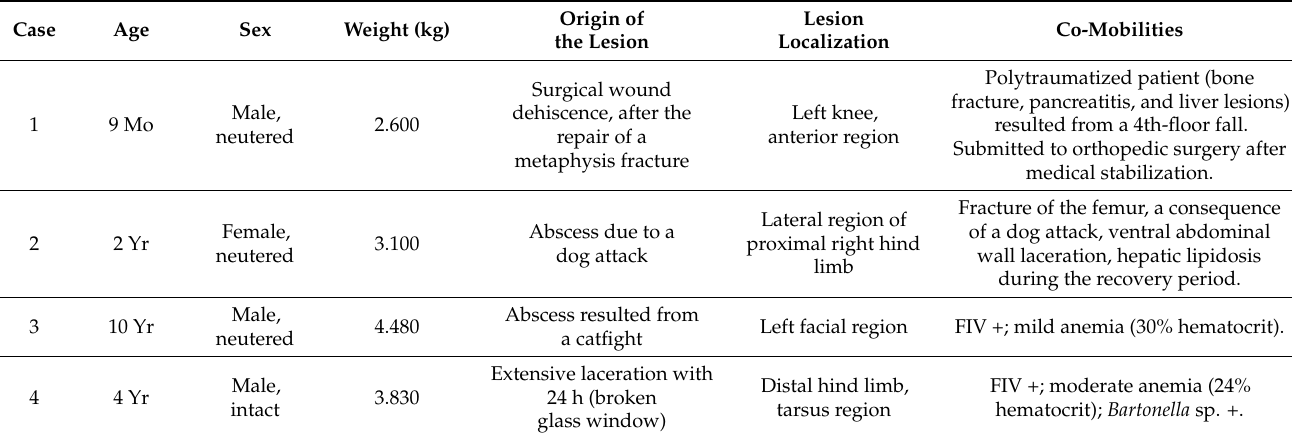
Table 2. Characteristics of feline enrolled in the